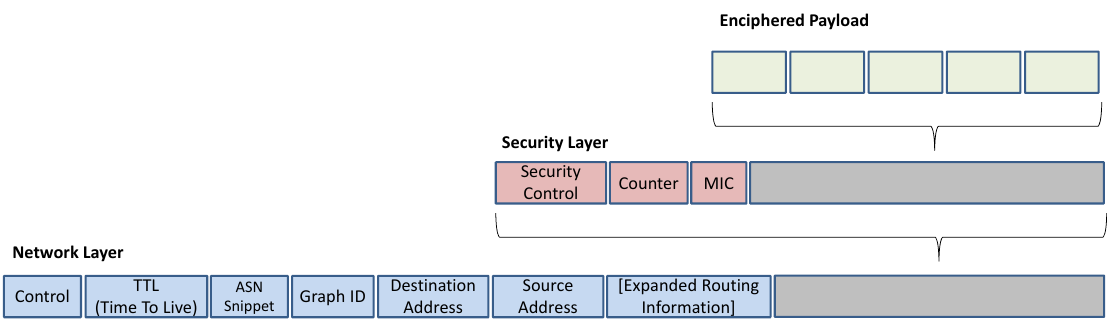
Figure 6. The WirelessHART network layer data unit structure. MIC: message integrity code; ASN: Abstract Syntax